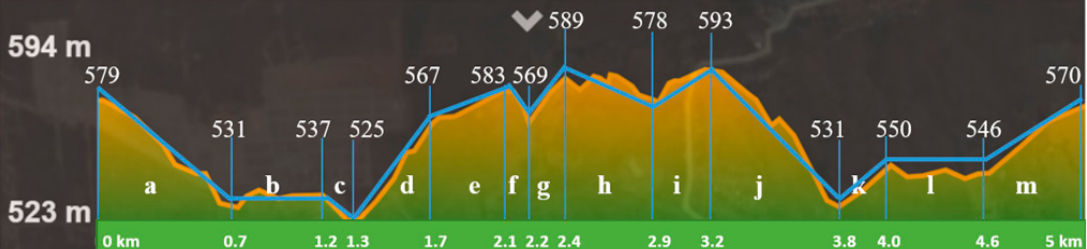
Figure 14. Santo Sepulcro Trail Altimetry; Araripe UGG. Source: Wikiloc; adapted for the study. a–m: Route sections